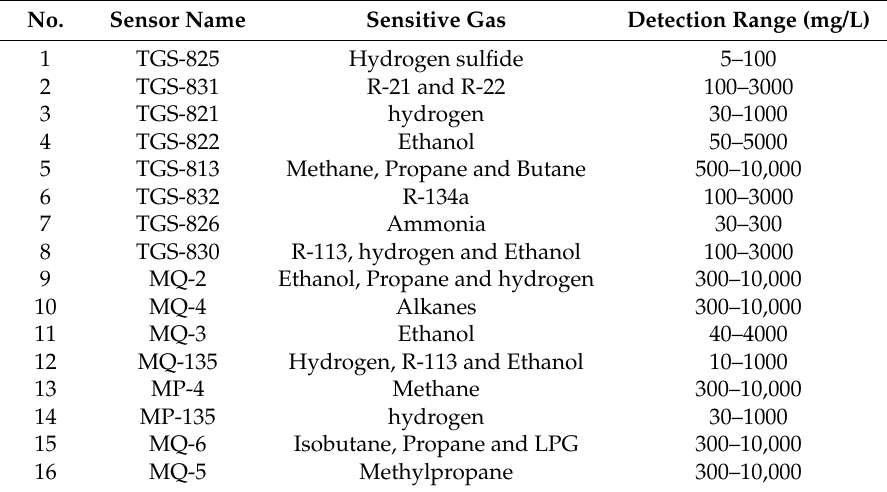
Figure 2. The block diagram of the intelligent nose analysis system. Table 2. Characteristics of sensors.